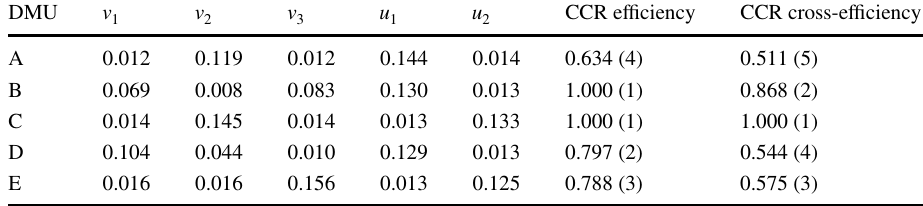
efficiency scores with a weight constraint ( 𝜃 = 10 )